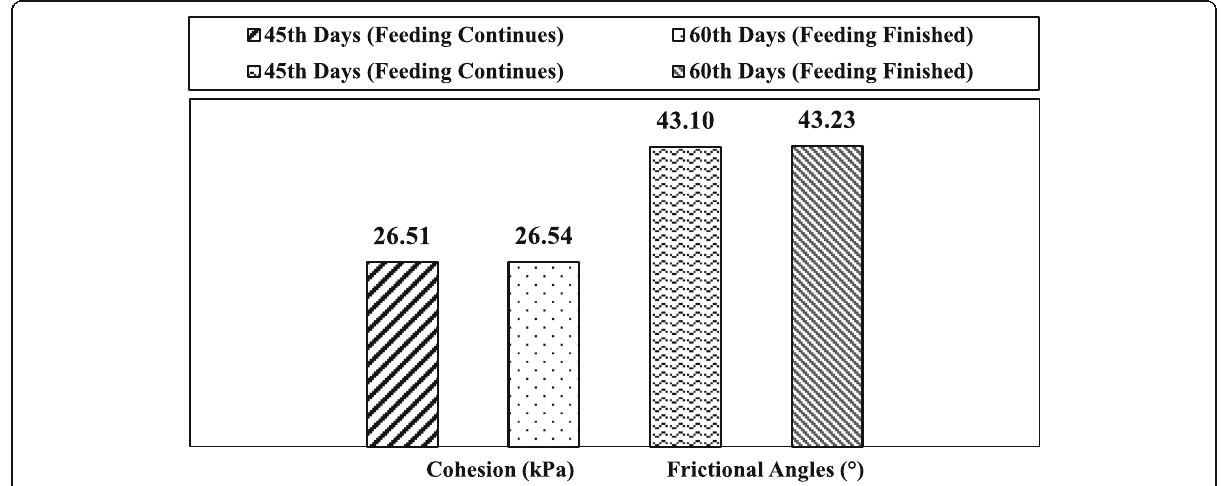
Fig. 4 Sandy soil parameters during and after the completion of